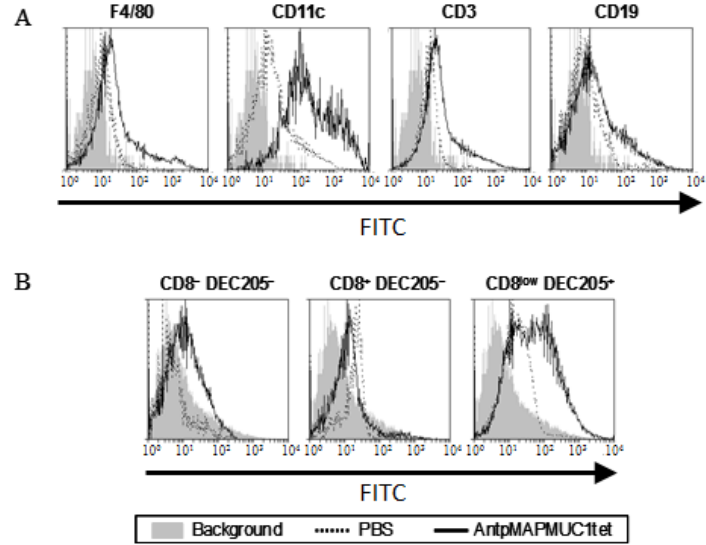
Figure 3. AntpMAPMUC1tet targets APC in vivo. Popliteal lymph nodes were isolated from mice ( n = 4) 18 h after i.d. immunisation with PBS or FITC-labelled AntpMAPMUC1tet. ( A ) Lymph node cells were stained with anti-CD3, CD19, CD11c and F4/80 antibodies. ( B ) Cells were labelled with